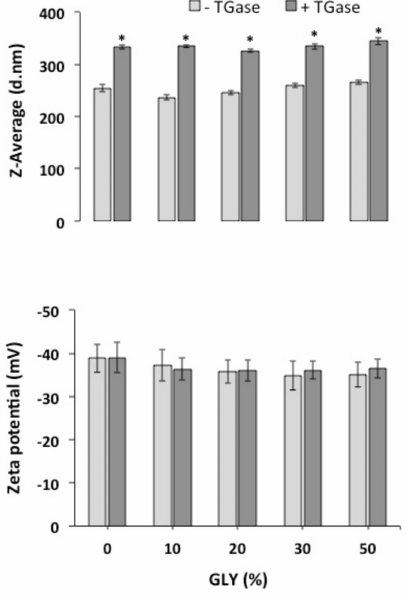
Figure 3. Z-Average and zeta potential, measured at pH 8.0, of protein concentrate (PC, 400 mg) FFSs containing di ff erent concentrations of glycerol (GLY) after incubation in the absence or presence of transglutaminase (TGase, 20 Units / g protein). Further experimental details are given in the text. * Significantly di ff erent values as compared to the ones obtained under the same experimental conditions in the absence of TGase ( p <